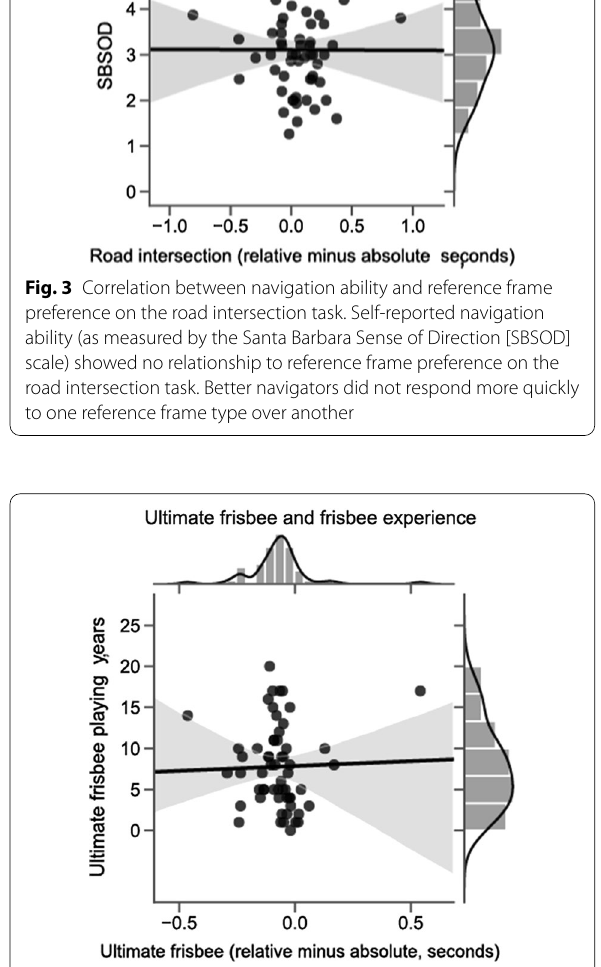
Fig. 4 Correlation between ultimate frisbee experience ability and reference frame preference on the ultimate frisbee task. Years playing ultimate frisbee showed no relationship to reference frame preference on the ultimate frisbee task. This finding holds no matter which measure is used to determine ultimate frisbee